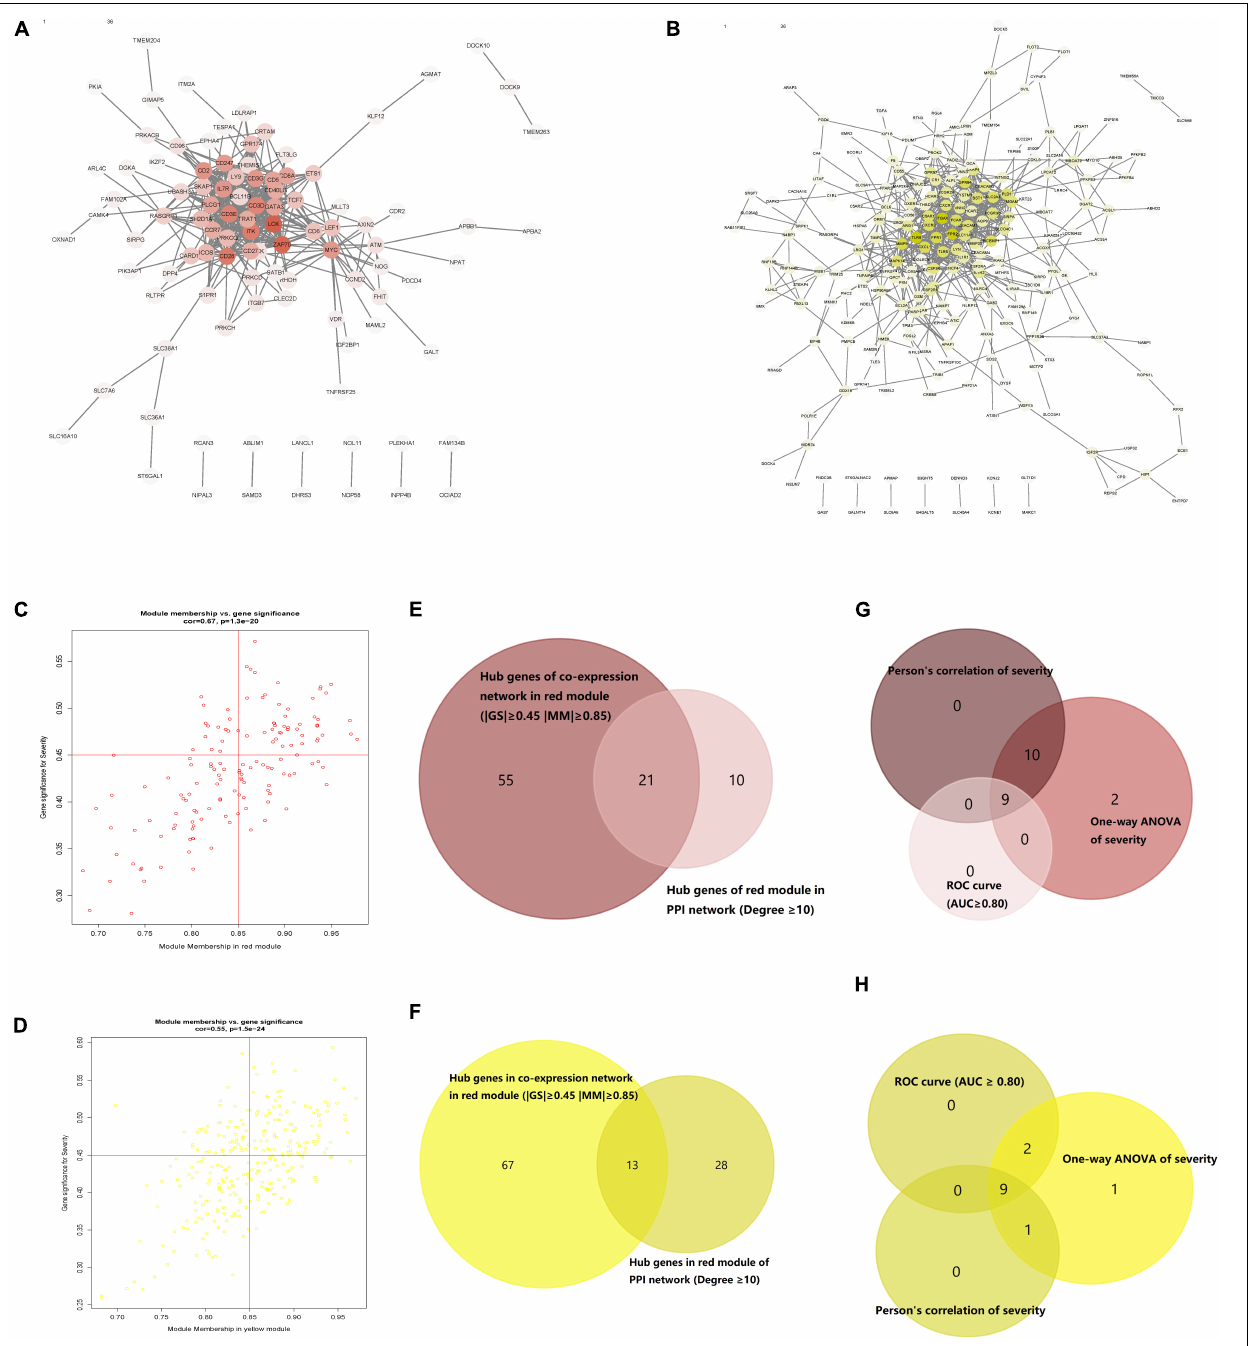
clarify the clinical significance and identify real hub